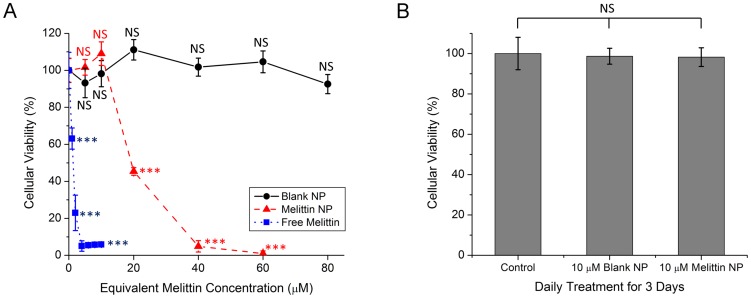
Effect of free melittin, blank NPs and mel-NPs on vaginal epithelial cell viability.(A) VK2 vaginal cell viability following treatment with a single dose of free melittin, blank NPs or mel-NPs for 12 hours. (B) VK2 vaginal cell viability following repeated treatment with fresh media (control) or a 10 µM equivalent melittin dose of blank NPs or mel-NPs once per day for 3 days. VK2 viability was determined using MTT assay. Error bars represent S.D. of n = 6 replicates. Labels indicate level of statistical significance compared to untreated control, NS p>0.05, *** p<0.001.